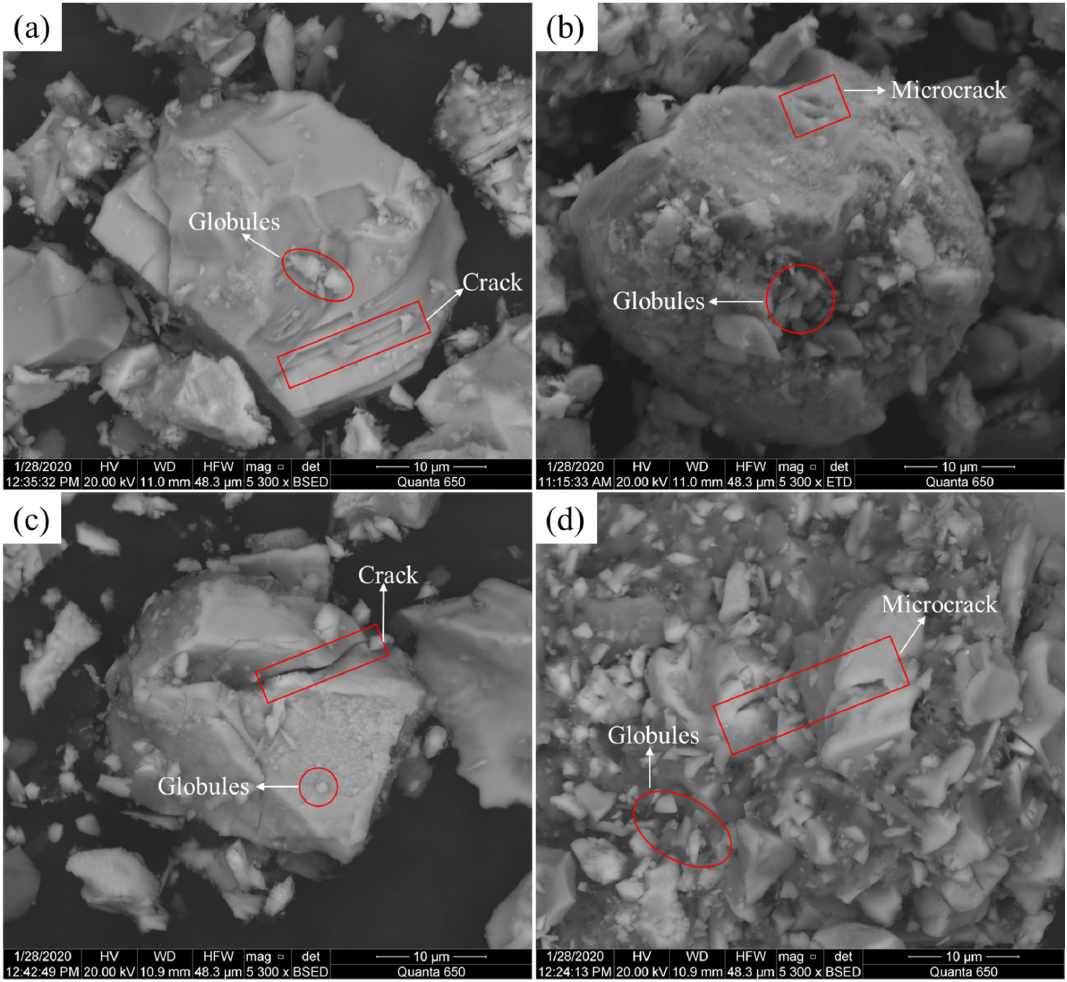
Figure 11. Scanning electron micrographs of the chalcopyrite-leached residues: ( a ) non-UAL at 50 ◦ C; ( b ) UAL at 50 ◦ C; ( c ) non-UAL at 80 ◦ C; and ( d ) UAL at 80 ◦ C (leaching conditions: ultrasound power